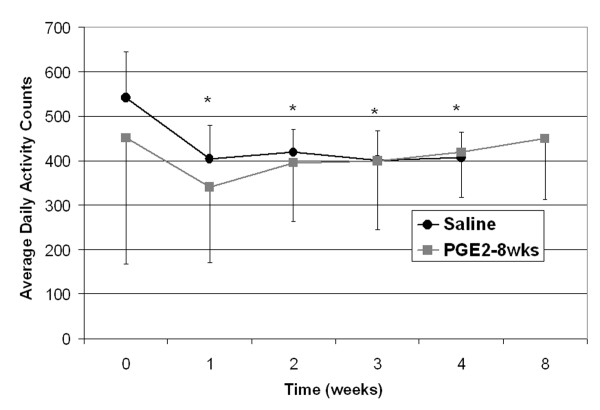
Average daily activity counts across weekly intervals for the animals. Counts at week zero were collected before injections were started. Injections stopped after 3 weeks in the PGE2-8 wk group. * Significant difference from week 0 (pre-injection) counts independent of group.(P < 0.05).